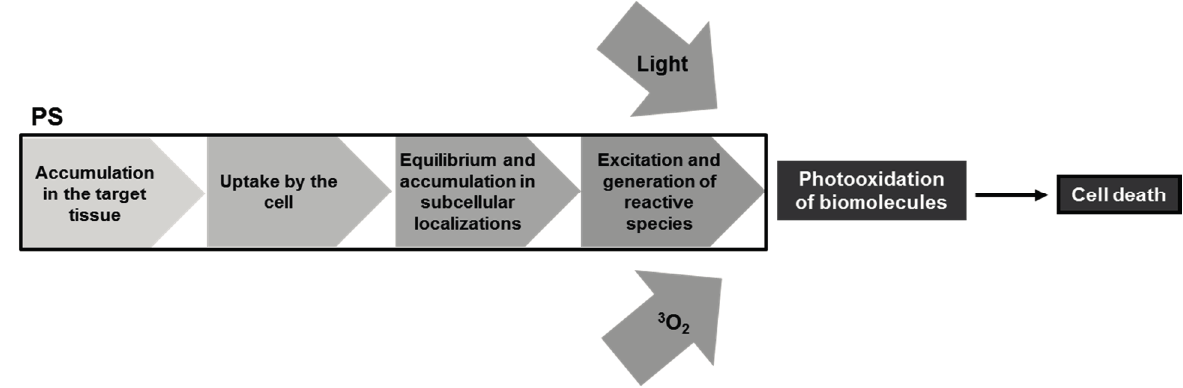
Figure 4. Proposed main steps that should happen with the photosensitizer (PS) in order to achieve cell